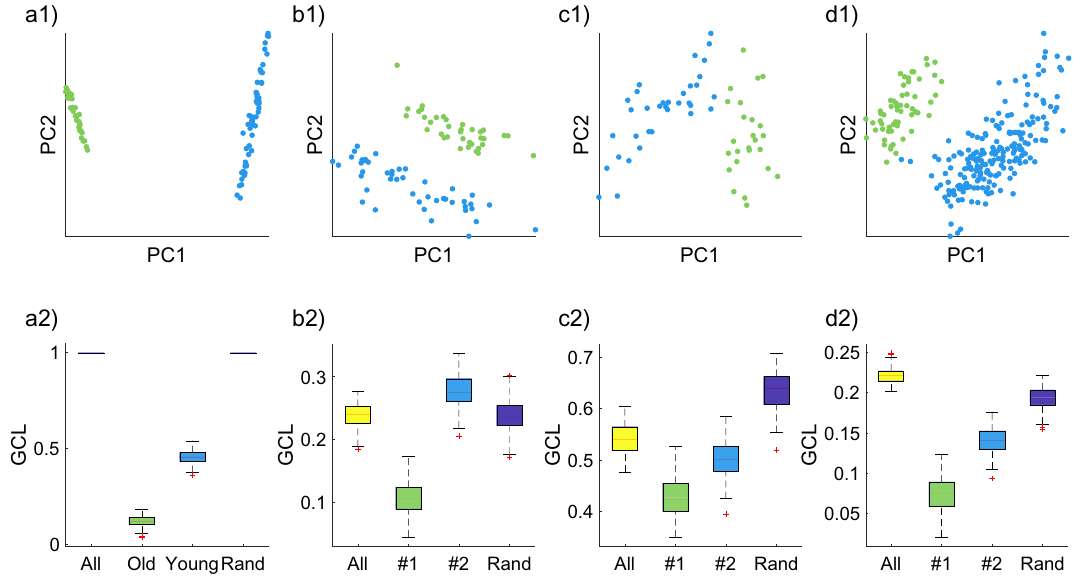
Figure 2. The effect of data heterogeneity on the GCL measure. ( a1 ) PCA plot of a cohort of cells which contains artificial heterogeneity by combining MPP cells from two different mice from the same data-set (young and old mice from Ref. 20 ). ( a2 ) GCL values of the different groups of cells in ( a1 ), including: the entire cohort 87 ), only the cells from the old mouse (‘Old’, M 34 ), only the cells from the young mouse (‘Young’, (‘All’, M = = 53 ), and a subset of cells randomly selected from the entire cohort (‘Rand’, M 34 ). ( b1 ) PCA plot of M = = a cohort of old long-term hematopoietic stem cells (LT-HSCs) from 20 . The blue and green colors represent detected clusters of cells, which are labeled as groups #1 and #2, respectively. ( b2 ) The corresponding GCL 82 , the number of cells in group #1, #2 and the values of the groups in ( b1 ). The total number of cells is M = 37 , M 45 and M 45 , respectively. ( c1 ) Same as ( b1 ) for MPP cells from 20 . ( c2 ) The random subset is M = = = 59 , the number of cells in corresponding GCL values of the groups in ( c1 ). The total number of cells is M = 25 , M 34 and M 34 , respectively. ( d1 ) Same as ( b1 ) but for group #1, #2 and the random subset is M = = = LT-HSCs from old C57 mouse from 19 . ( d2 ) The corresponding GCL values of the groups in ( d2 ). The total 256 , the number of cells in group #1, #2 and the random subset is M 58 , M 198 number of cells is M = = = 198 , respectively. Box plots represent the distributions of GCL values calculated for 100 jackknife and M = 50 random choices of gene group realizations, each consists of 80% of the cells and calculated using m = divisions. The data consists of the top 500 expressed genes. These results demonstrate how heterogeneity in the data can cause spurious GCL values, while dividing the data into its natural clusters yield distinct GCL values. Random groups are comprised of random cells from the entire cohort, with the number of cells equals to the size of group #2. Centre line, median; box limits, upper and lower quartiles; whiskers, 1.5 interquartile range; points,